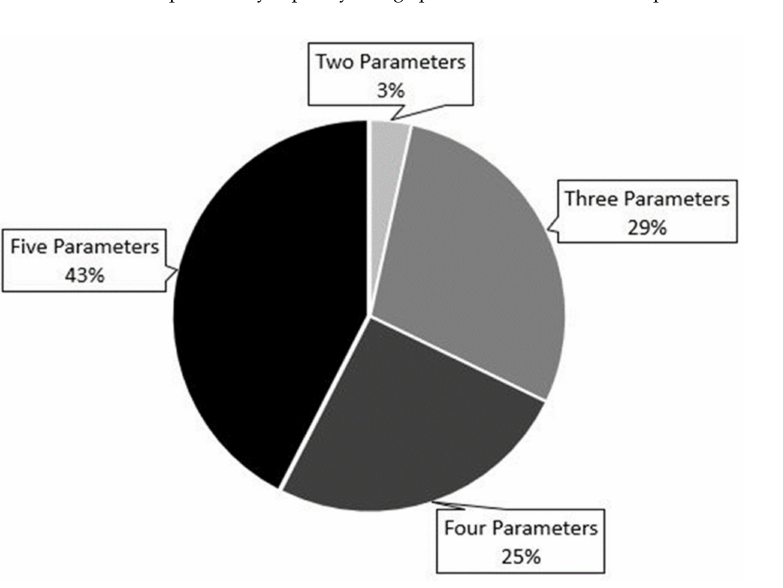
Figure A1. Distribution of patients according to the number of available parameters used for risk stratification (World Health Organization Functional Class, 6-minute walking distance, serum natriuretic peptide level, right atrial pressure, cardiac